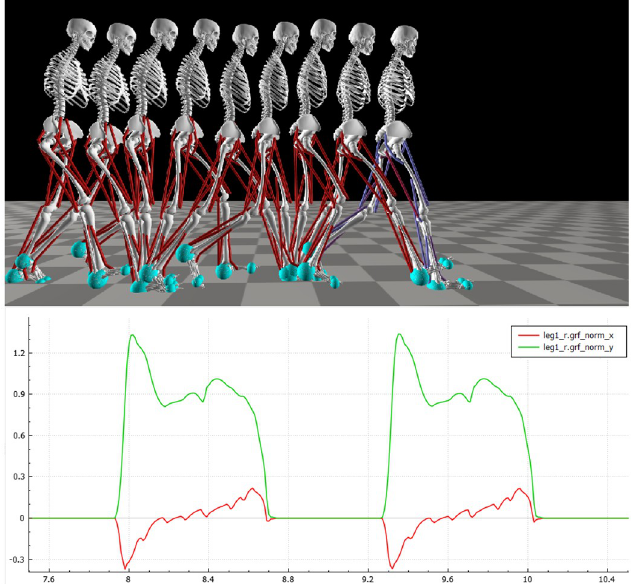
Fig 6. Representation of gait behavior with snapshots taken at different frames of for the speed modulation solution with target speed equal to 1.2 m/s. The instant taken is represented together with the behavior of vertical and horizontal ground reaction